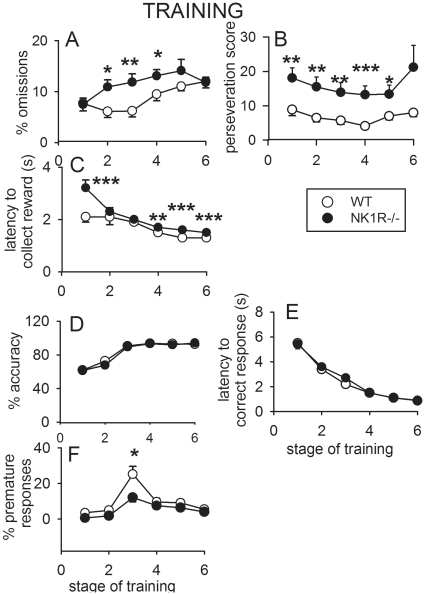
The performance of wildtype and NK1R-/- mice during training in the 5-CSRTT.
% Omissions, perseveration and latency to collect the reward are all greater in NK1R-/- mice than wildtypes, regardless of time of day (A–C). There was no difference in accuracy (D) or latency to correct response (E), but premature responses (F) were greater in wildtypes, especially during Stage 3 of training. Points show mean ± s.e.m. * P<0.05, ** P<0.01, *** P<0.001. N = 23–24 per group.